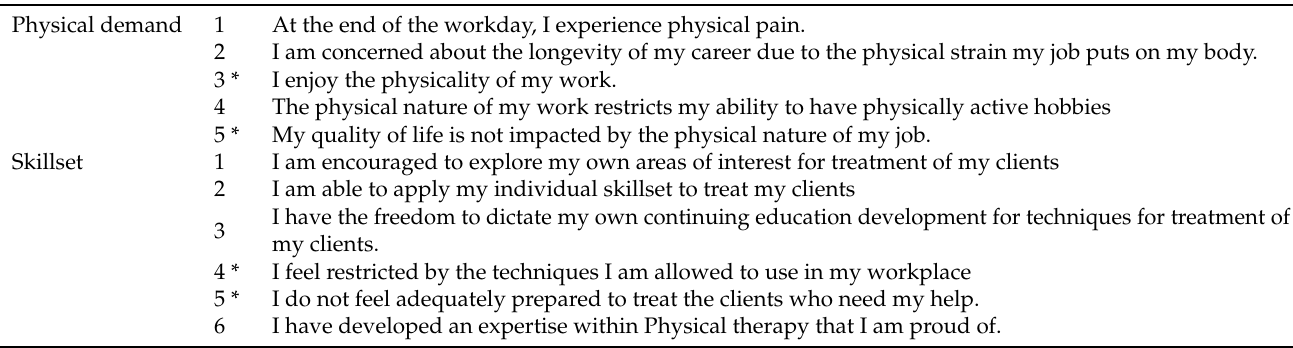
Table 1. Physical Therapy Job Satisfaction